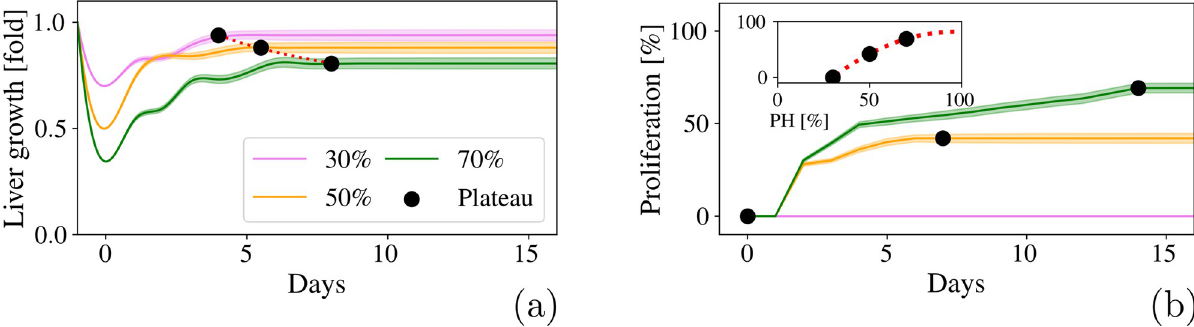
Fig 8. Predictions of a 50% PH compared to the outcomes of 30% and 70% PH. (a) Fold-increase in the liver volume after 30% (violet), 50% (orange) and 70% (green) PH. Black dots represent the time at which the volume increase reaches a plateau and the red dotted line is a polynomial fitting. (b) Percentage of hepatocytes that proliferates during liver regeneration. Black dots represent the time at which the proliferation increase reaches a plateau. Inset: Proliferation percentage in terms of the PH. The red dotted line represents a polynomial fitting. Shaded regions represent the standard deviations of 40